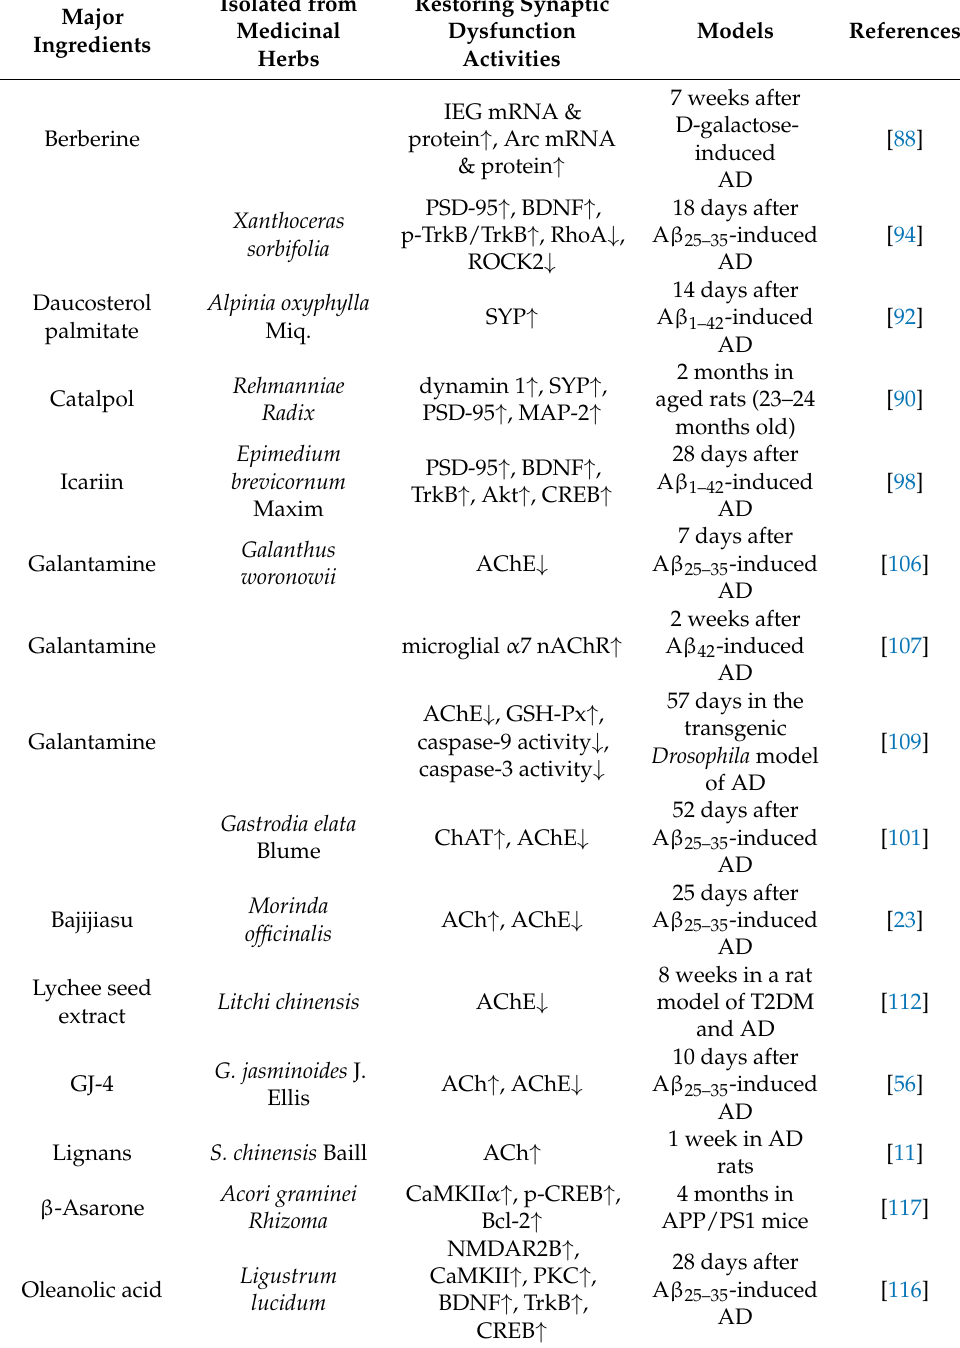
Table 5. MHDIs that ameliorate A β -induced synaptic dysfunction in AD animal